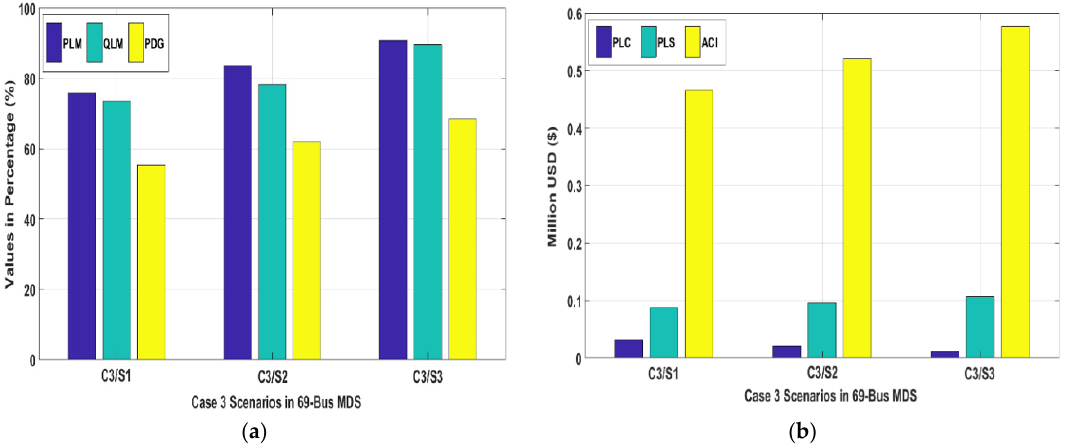
Figure 16. Case 3 Scenarios for 69-bus MDS (U_Max) ( a ) Performance evaluation in-terms of PLM , QLM and PDG ; ( b ) Performance evaluation in-terms of PLC , PLS and ACI .